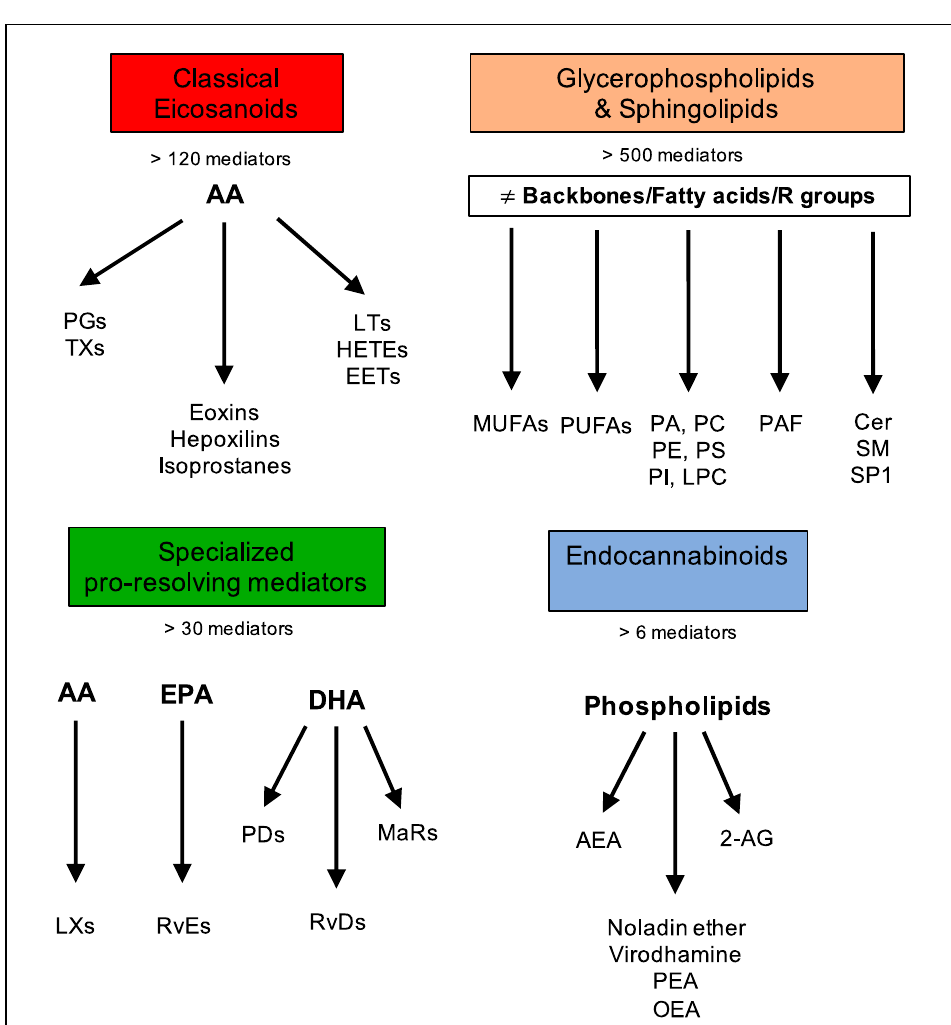
Figure 1. Main families of bioactive lipids and their mediators.